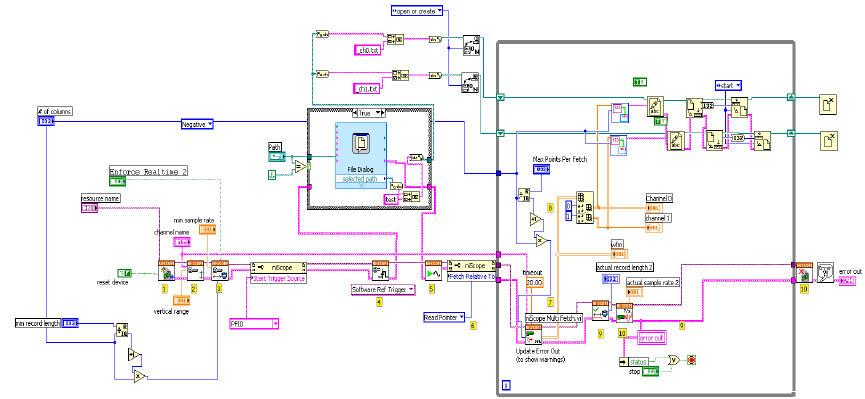
Figure 4. Schematic representation of the SF dual-channel LabView ® instrument control software. The instrument virtual software prepares data acquisition to a sample rate of 1536, 3072, and 6144 data points per second and creates two text files to store the output V DC (t) and V AC (t) signals in channel 0 and 1, respectively. The virtual range corresponds to the voltage variation in the detector from -5V up to +5V. The collection protocol can be started manually or by a triggering signal (PF10) when the stopping syringe mechanism is closed (Figure 5). The waiting period for receiving the triggering signal is set at 20 s. When saturation is reached at 5V, the data acquisition is truncated. The background is collected with the buffer solution to eliminate it from the r(t) and F(t) traces.